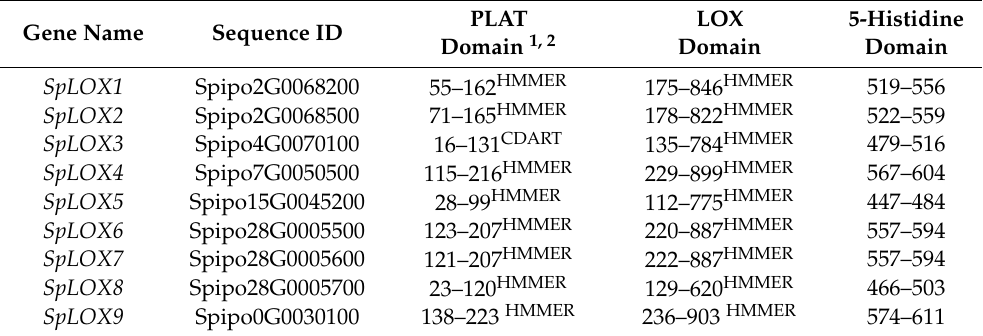
Table 2. Location of signature domains in Spirodela LOX protein sequences. PLAT, polycystin-1, lipoxygenase,